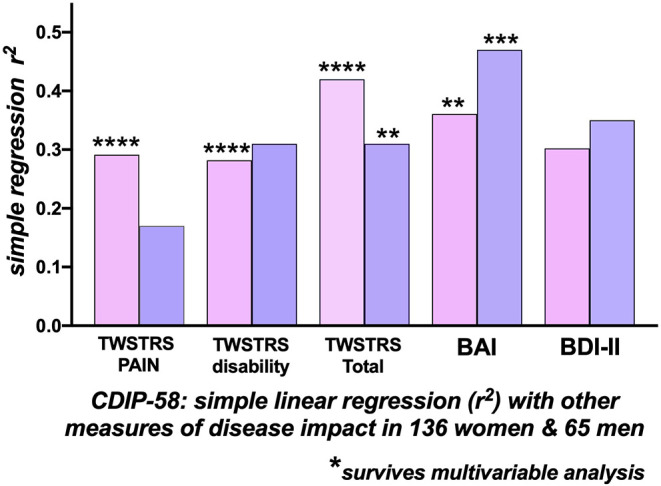
Correlations with the Cervical Dystonia Impact Profile-58 (CDIP-58) as an index of Quality of Life. Correlations of CDIP-58 with other measures of disease impact in 136 women (pink bars) and 65 men (blue bars) with cervical dystonia. The height of the bars indicates the r-squared relationship between the CDIP-58 Total Scale score and the clinical measure. In women there were significant correlations, surviving multi-variable analysis, between the CDIP-58 with TWSTRS-2 Total, Pain, Disability and Beck Anxiety Inventory (BAI). In men, only the TWSTRS Total and BAI correlations survived multi-variable analysis. [BAI, Beck Anxiety Inventory; BDI-II, Beck Depression Inventory; TWSTRS, Toronto Western Spasmodic Torticollis Rating Scale) (*p < 0.05; **p < 0.01; ***p < 0.001; ****p < 0.0001)].